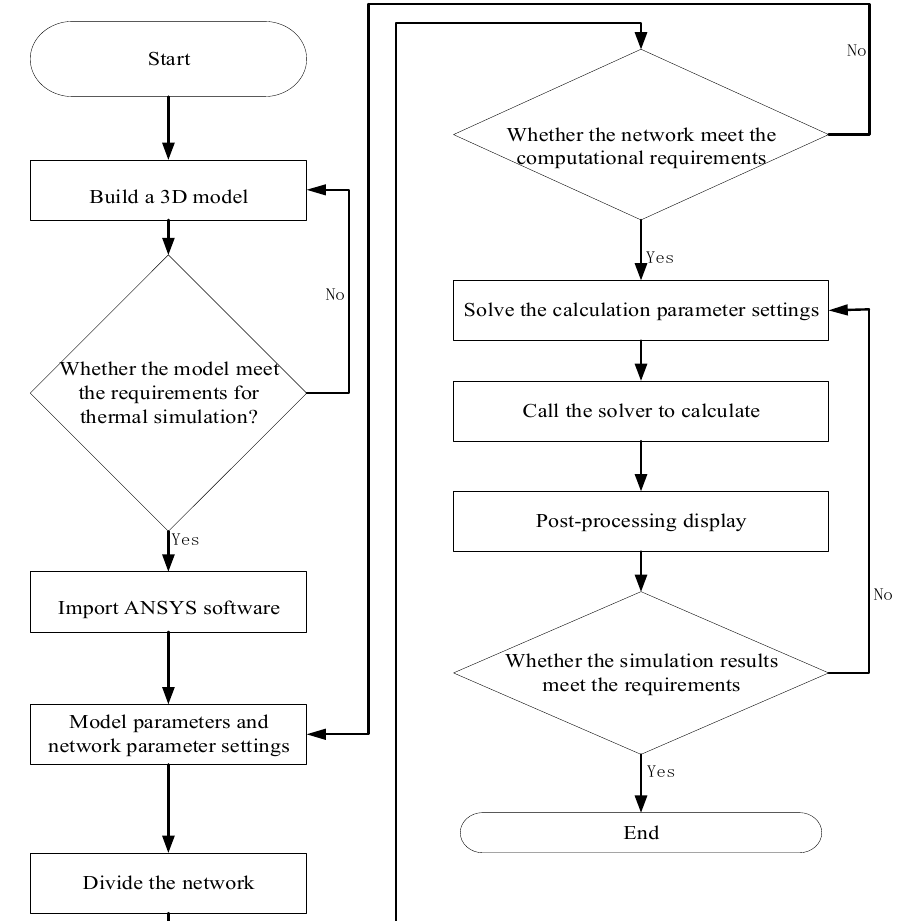
Figure 2. Thermal analysis flow chart. Table 1. Boundary condition parameter setting